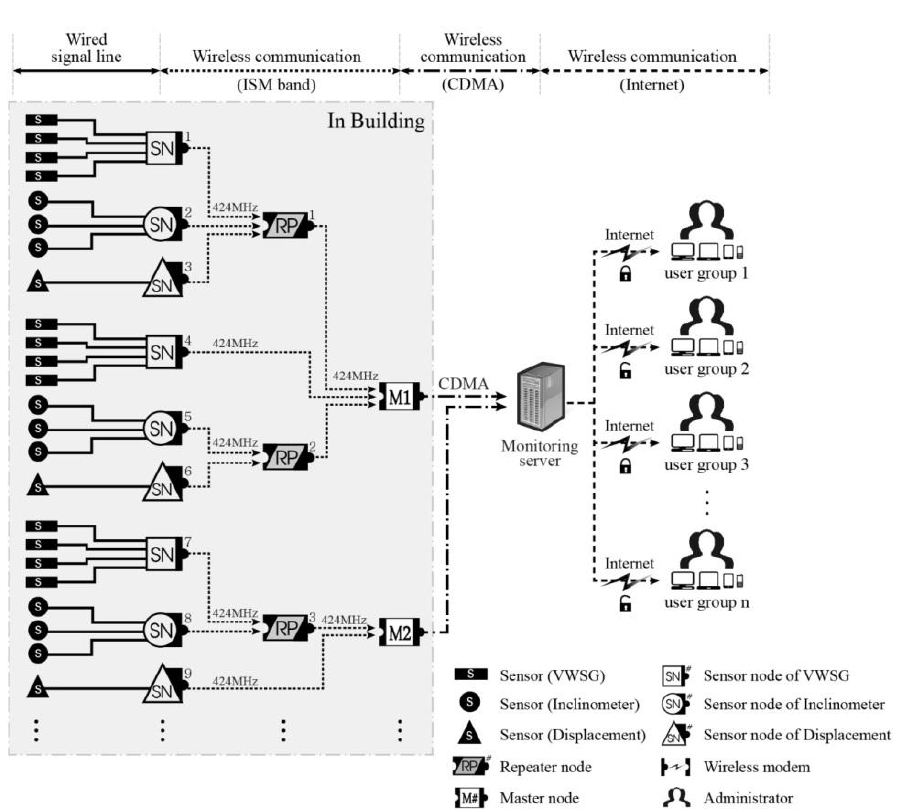
Figure 1. WSN for